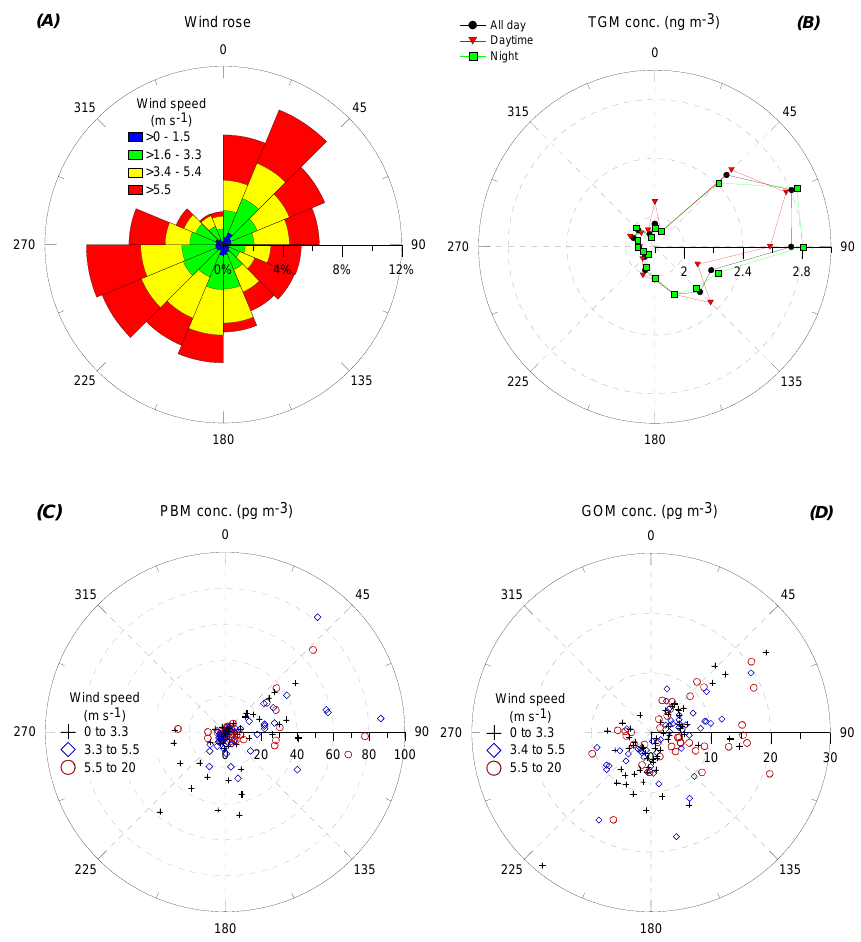
Fig. 4. (A) Wind rose for the entire study period; (B) wind rose for TGM; (C) wind rose for all PBM data sets; and (D) wind rose for all GOM data